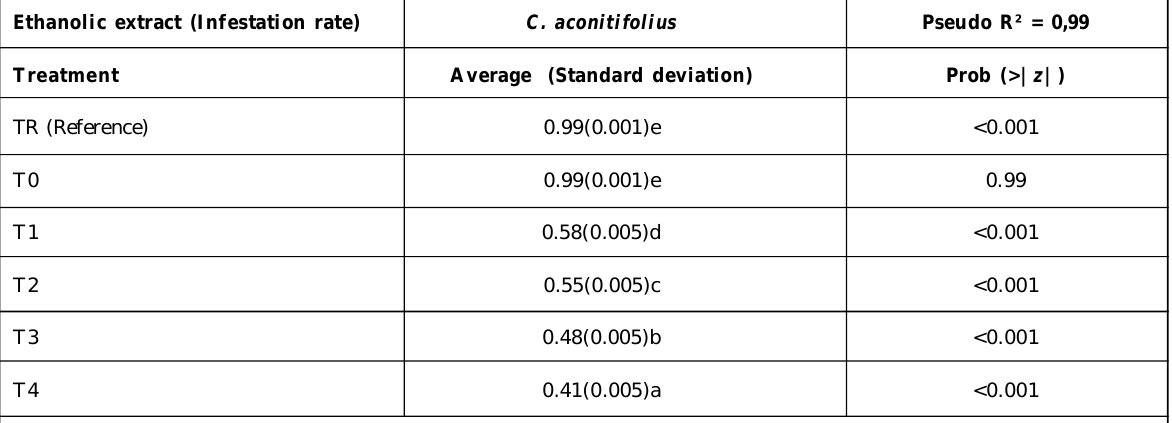
Table 4 : Result of beta regression applied to infestation rate of C. maculatus under the effect of ethanol extract of C. aconitifolius